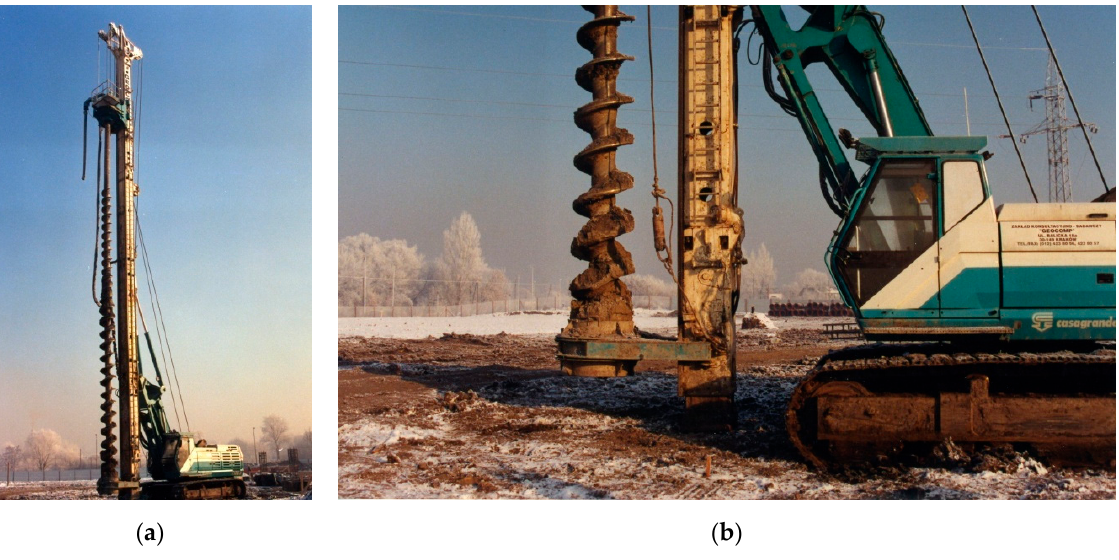
Figure 1. ( a ) Piling machine ( b ) Auger.